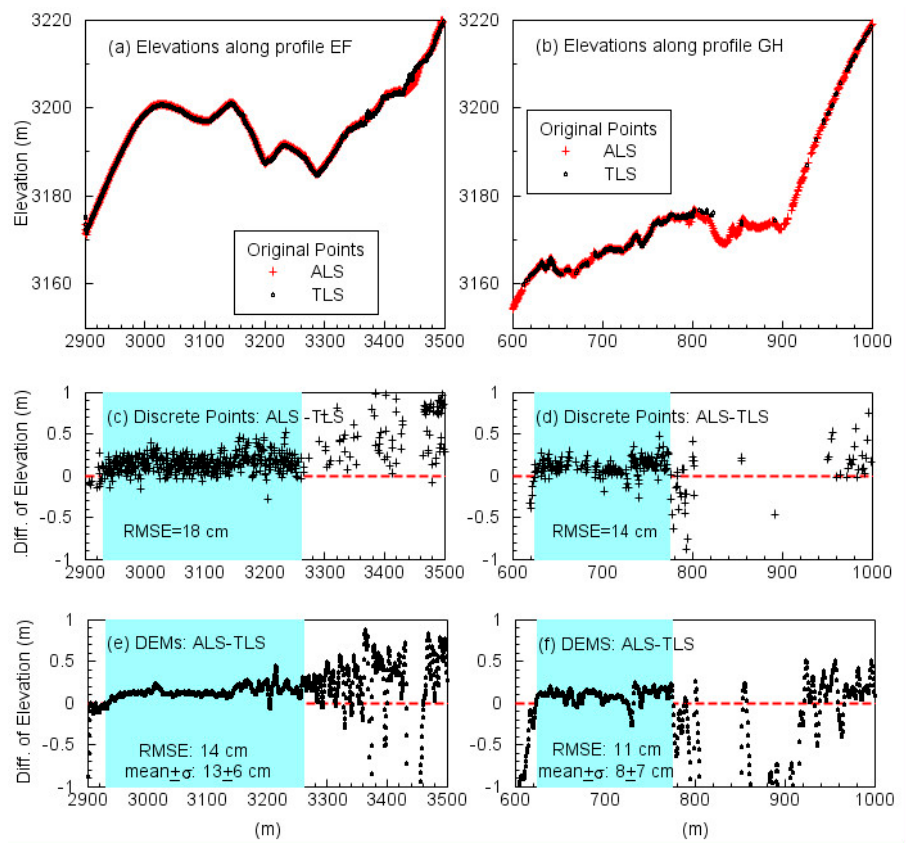
Figure 13. Comparisons of the elevation measurements from the ALS and TLS datasets depicted in Figure 11. The left column is for the elevations along profile EF; the right column is the elevations along profile GH. The RMSE and mean values marked in subplots are calculated from the datasets within the shaded areas that both ALS and TLS datasets have continuous data coverage.